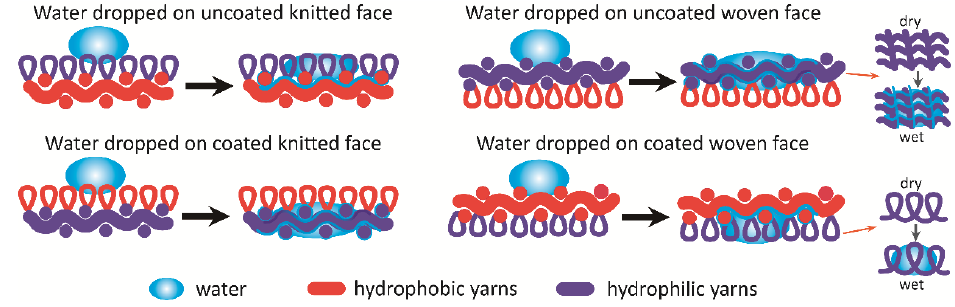
Figure 10. Schematic illustration of a possible mechanism of transplanar (between hydrophobic face and hydrophilic face) and in-plane (on woven face and knitted face) water transport of the treated bifacial fabrics.